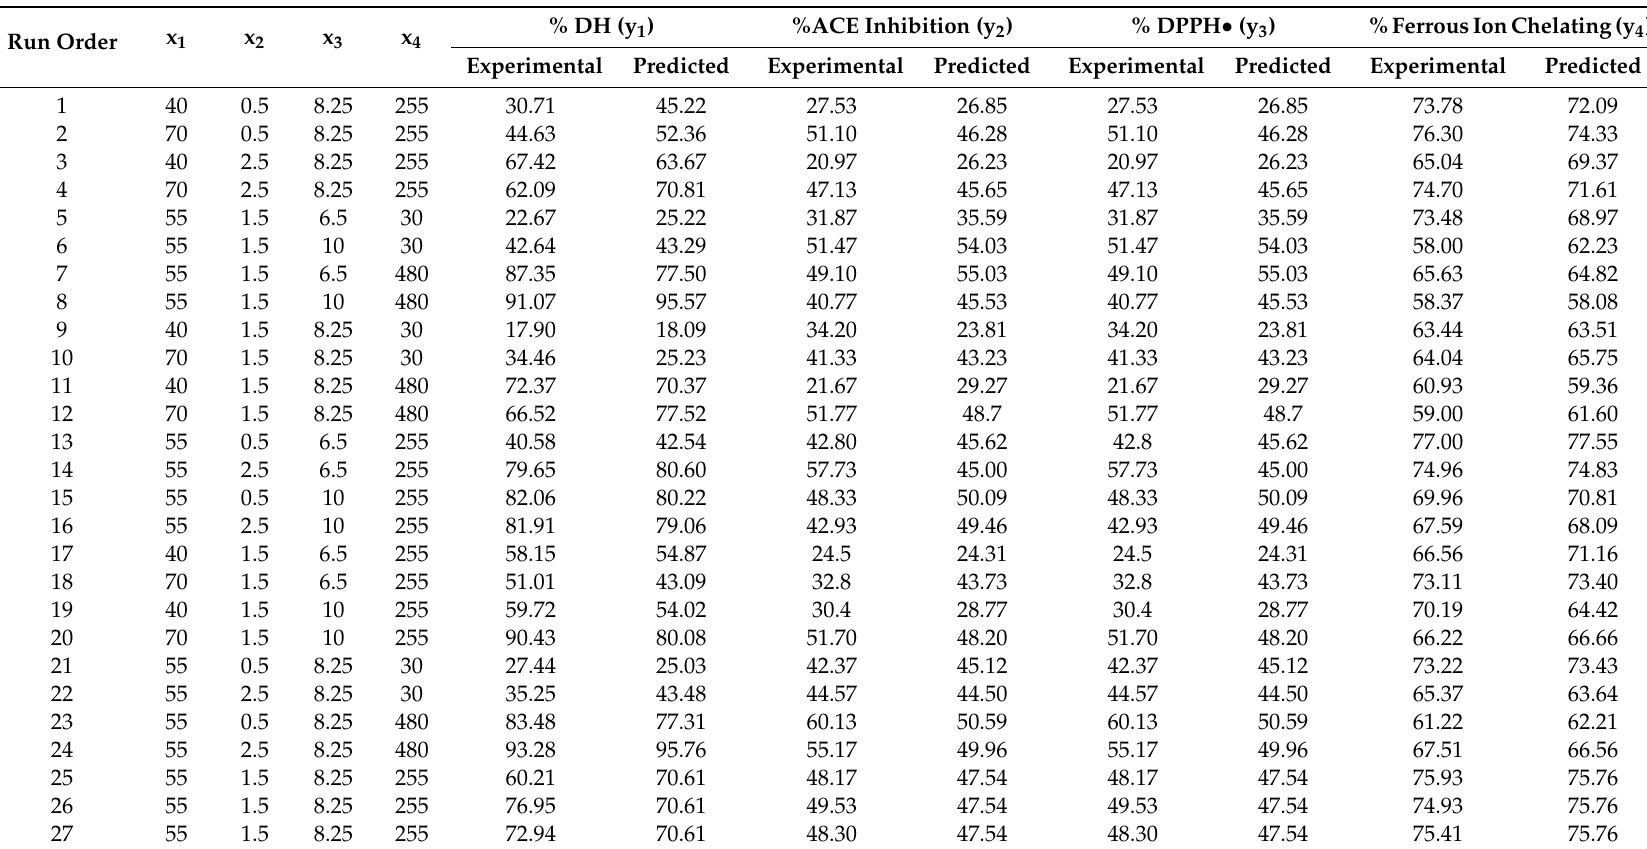
Table 2. Behnken design, predicted and experimental values of four response variables (y 1 , y 2 , y 3 , y 4 ) as a ff ected by temperature ( ◦ C), E / S ratio (%), pH and hydrolysis time